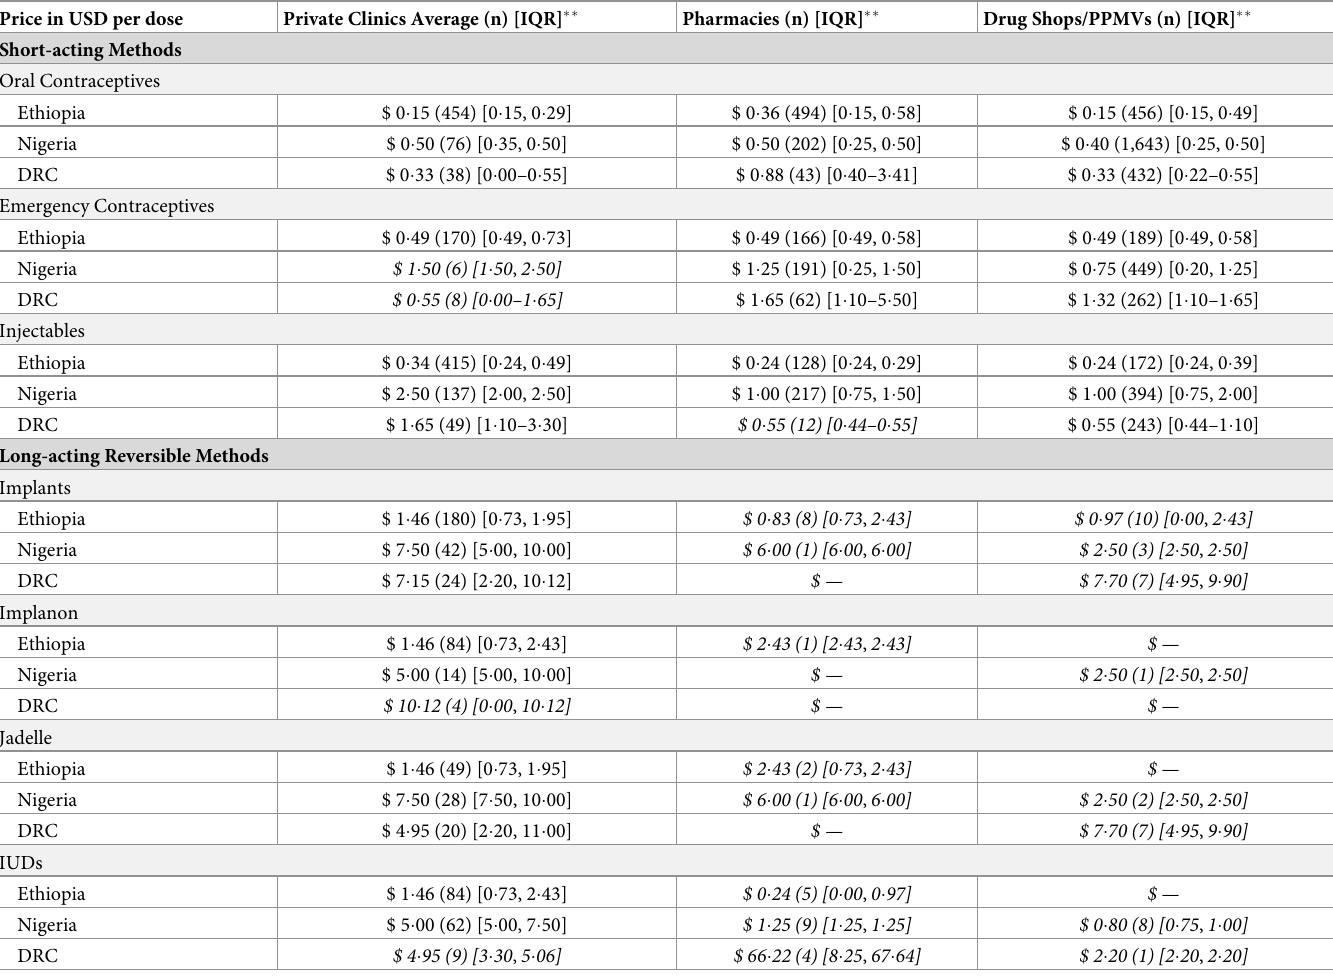
(cid:3) Majority of methods are free in the public sector and thus pricing is only presented for the private sector. (cid:3)(cid:3) Text in italics denotes strata with less than 15